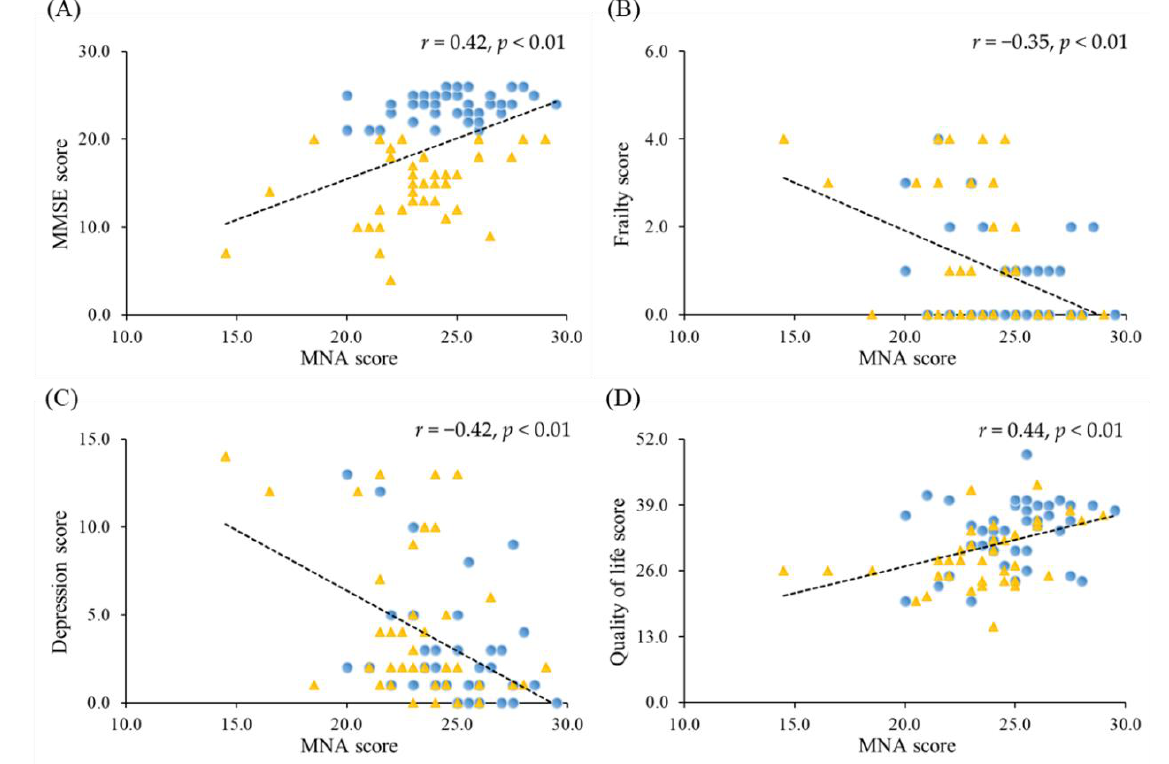
Figure 2. Correlations between nutritional status and the severity of dementia, frailty, depression, and quality of life. ( A ) Correlation between MNA and MMSE score ( r = 0.42; p < 0.01). ( B ) Correlation between MNA and frailty score ( r = − 0.35; p < 0.01). ( C ) Correlation between MNA and depression score ( r = − 0.42; p < 0.01). ( D ) Correlation between MNA and quality of life score ( r = 0.44; p < 0.01). Blue dot is mild dementia; yellow triangle is moderate dementia. MMSE, Mini Mental State Examination; MNA, mini nutritional assessment.